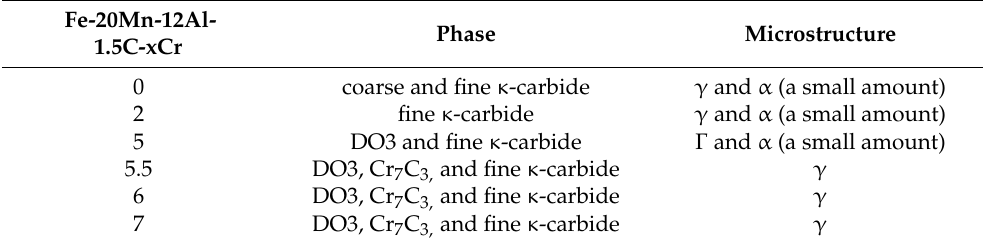
Table 1. Microstructure and phase of Fe-20Mn-12Al-1.5C-xCr